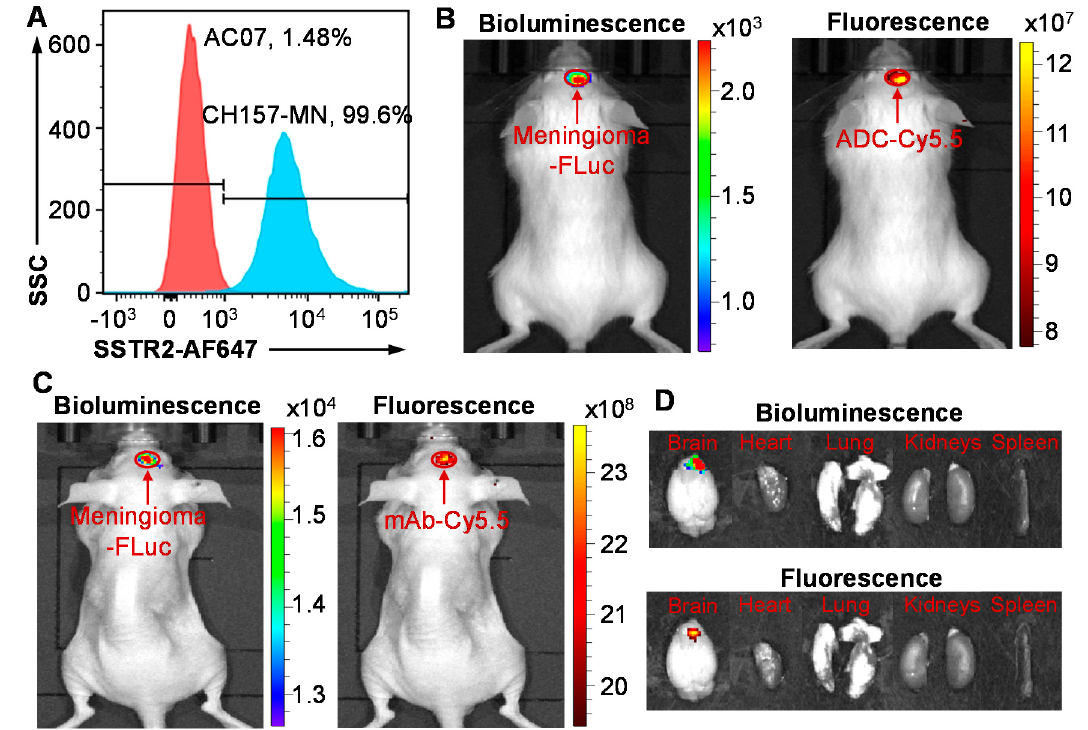
Figure 2. Meningioma targeting by anti-SSTR2 mAb and/or ADC. ( A ) Evaluation of the SSTR2 surface binding rate of mAb-AF647 in meningioma cell CH157-MN (blue) and normal arachnoidal cell AC07 (control, red) by flow cytometry analysis. Cells were stained with 1 μ g of mAb-AF647 per million cells at room temperature for 30 min. ( B ) In vivo evaluation of specific targeting to meningioma (CH157-MN-FLuc) xenograft in NSG mice by anti-SSTR2 mAb-Cy5.5 using IVIS imaging. ( C ) In vivo meningioma targeting by anti-SSTR2 ADC-Cy5.5 in nude mice. ( D ) Ex vivo images of tumor and important organs including brain, heart, lung, kidney, and spleen. Total of 30 μ g mAb-Cy5.5 or ADC-Cy5.5 was i.v. injected into mice ( n = 3) through tail vein. Live-animal or ex vivo images were taken at 24 h post ADC injection.